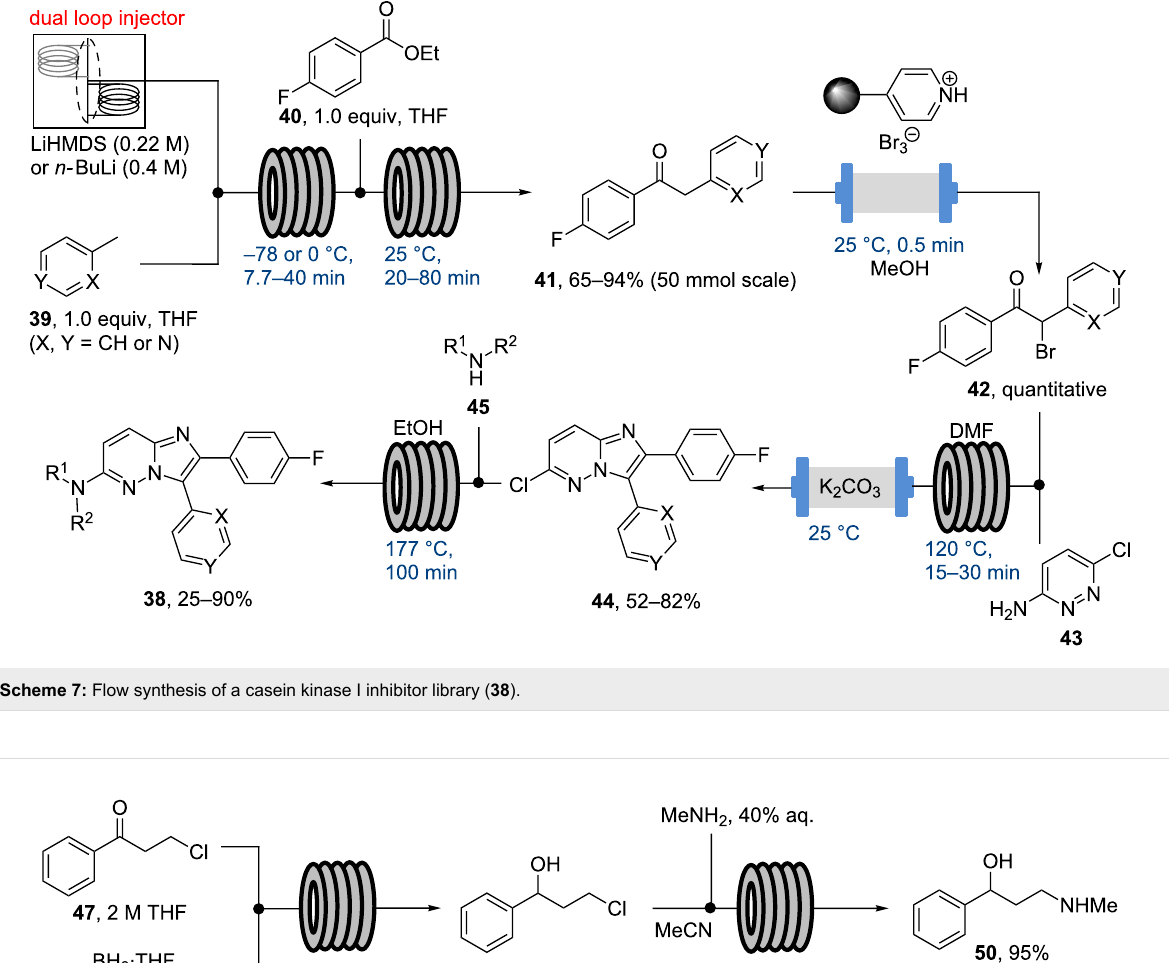
Scheme 7: Flow synthesis of a casein kinase I inhibitor library ( 38 ).